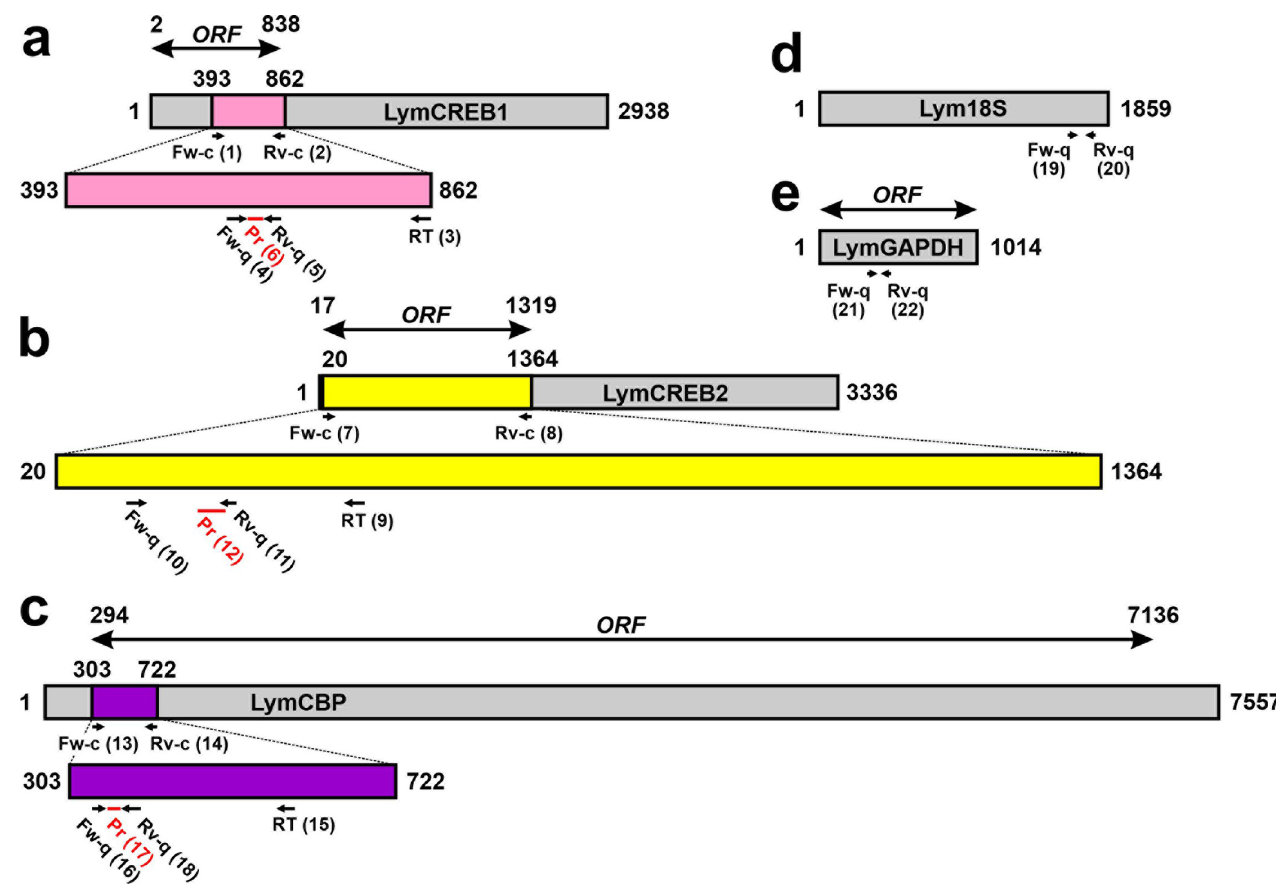
Fig 2. Positions of primers and probes used in the experiments. (A) LymCREB1 [GenBank Accession No.: AB041522], (B) LymCREB2 [AB083656], (C) LymCBP [AB217914], (D) Lym18S [Y09018], and (E) LymGAPDH [MH687363]. Fw-c: forward primer for cloning, Rv-c: reverse primer for cloning, RT: gene-specific primer for reverse transcription, Fw-q: forward primer for qPCR, Rv-q: reverse primer for qPCR, Pr: TaqMan probe. Numbers in parentheses indicate the corresponding primers and probes shown in Table 1. Numbers without parentheses indicate nucleotide numbers. ORF: open reading frame.